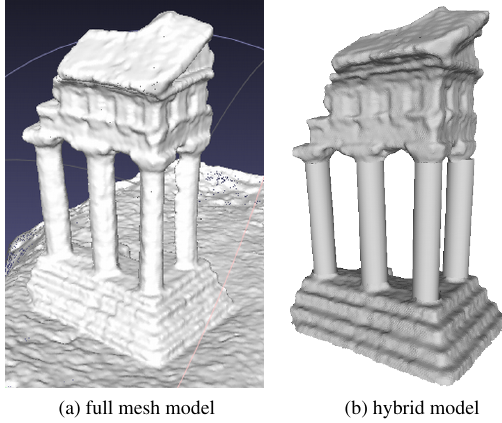
Figure 4. Full-mesh and hybrid models of the temple test case.